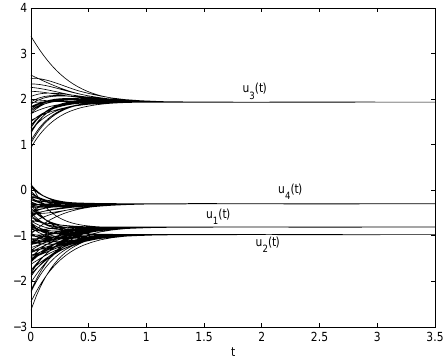
Fig. 4. Transient behavior of the output trajectories of (19)- (20) with 30 random initial points in Example